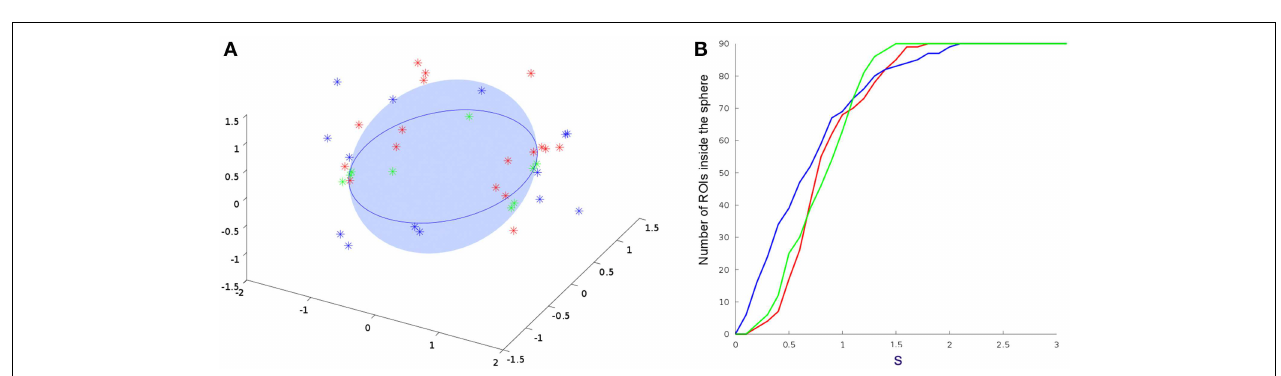
FIGURE 5 | Comparisons between DTI and all other embedded fMRI networks. (A) 3D projections from Equation (7). Only points outside the sphere are plotted. (B) Number of ROI’s inside the sphere of radius of s . Results from a single subject, average connectivity and multiplex networks are represented by the red, blue,